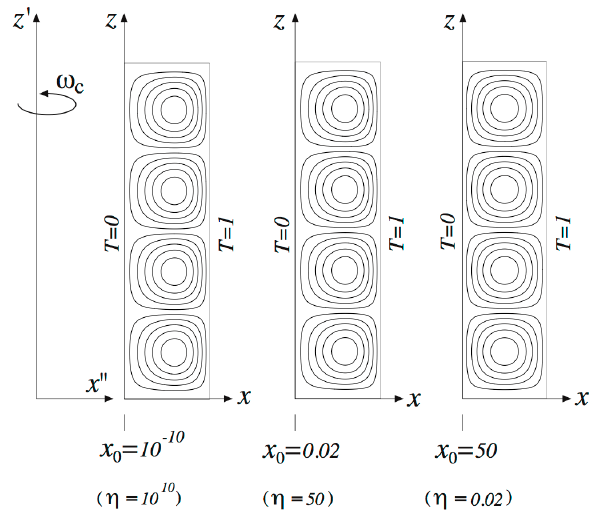
( b ) Figure 5. ( a ) The variation of the critical values of the centrifugal Rayleigh numbers as a function of η ; ( b ) The stability map on the Ra ω − Ra ω o plane showing the division of the plane. (Reprinted from [40], with permission from Springer.) The results for the convective flow field are presented graphically in Figure 6 following Vadasz [40], where it was concluded that the effect of the variation of the centrifugal acceleration within the porous layer is definitely felt when the box is close to the axis of rotation, corresponding to an eccentric shift of the convection cells towards the sidewall at x = 1 . However, when the layer is located far away from the axis of rotation (e.g., x 0 = 50 ) the convection cells are concentric and symmetric with respect to x = 1 2 as expected for a porous layer subject to gravity and heated from below (here “below” means the location where x = 1 ). Although the linear stability analysis is sufficient for obtaining the stability condition of the motionless solution and the corresponding eigenfunctions describing qualitatively the convective